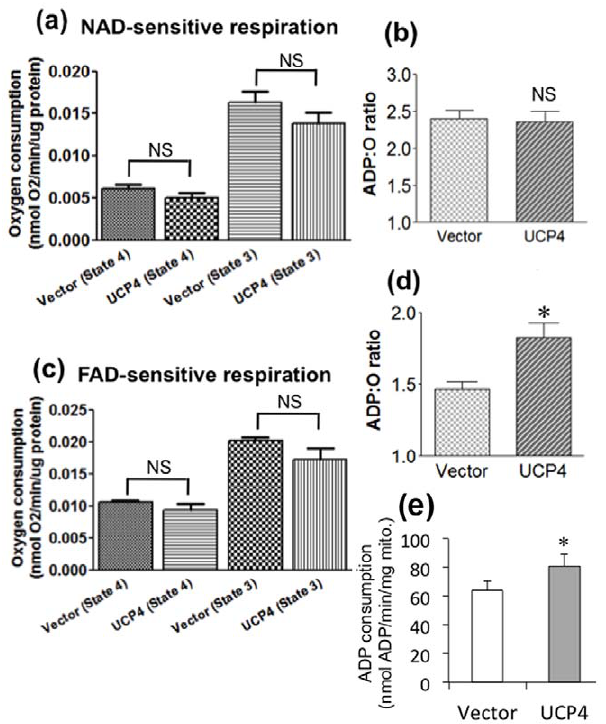
Figure 4. Mitochondrial oxygen consumption and ADP:oxygen (ADP:O) ratio of isolated mitochondria from vector control and UCP4-overexpressing cells. ADP-stimulated ( state 3 ) and resting ( state 4 ) respiration rates are shown for mitochondria maintained in